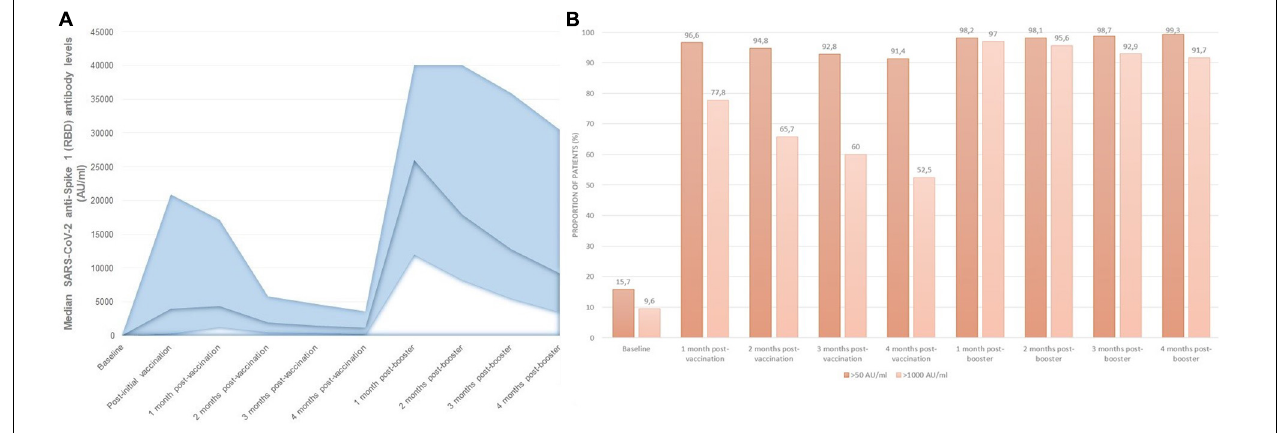
FIGURE 3 | Monthly SARS-CoV-2 serological follow-up: (A) median monthly anti-S(RBD) antibody levels, (B) proportion of patients with positive and effective humoral responses at each time point during follow-up.